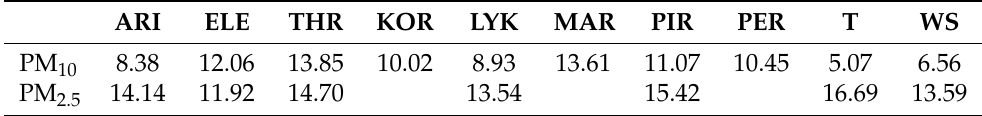
Table 7. Relative importance (%) of the input data for the two cases of PM 10 and PM 2.5 FFNN models, where both PM concentrations and meteorological parameters (T, WS) are